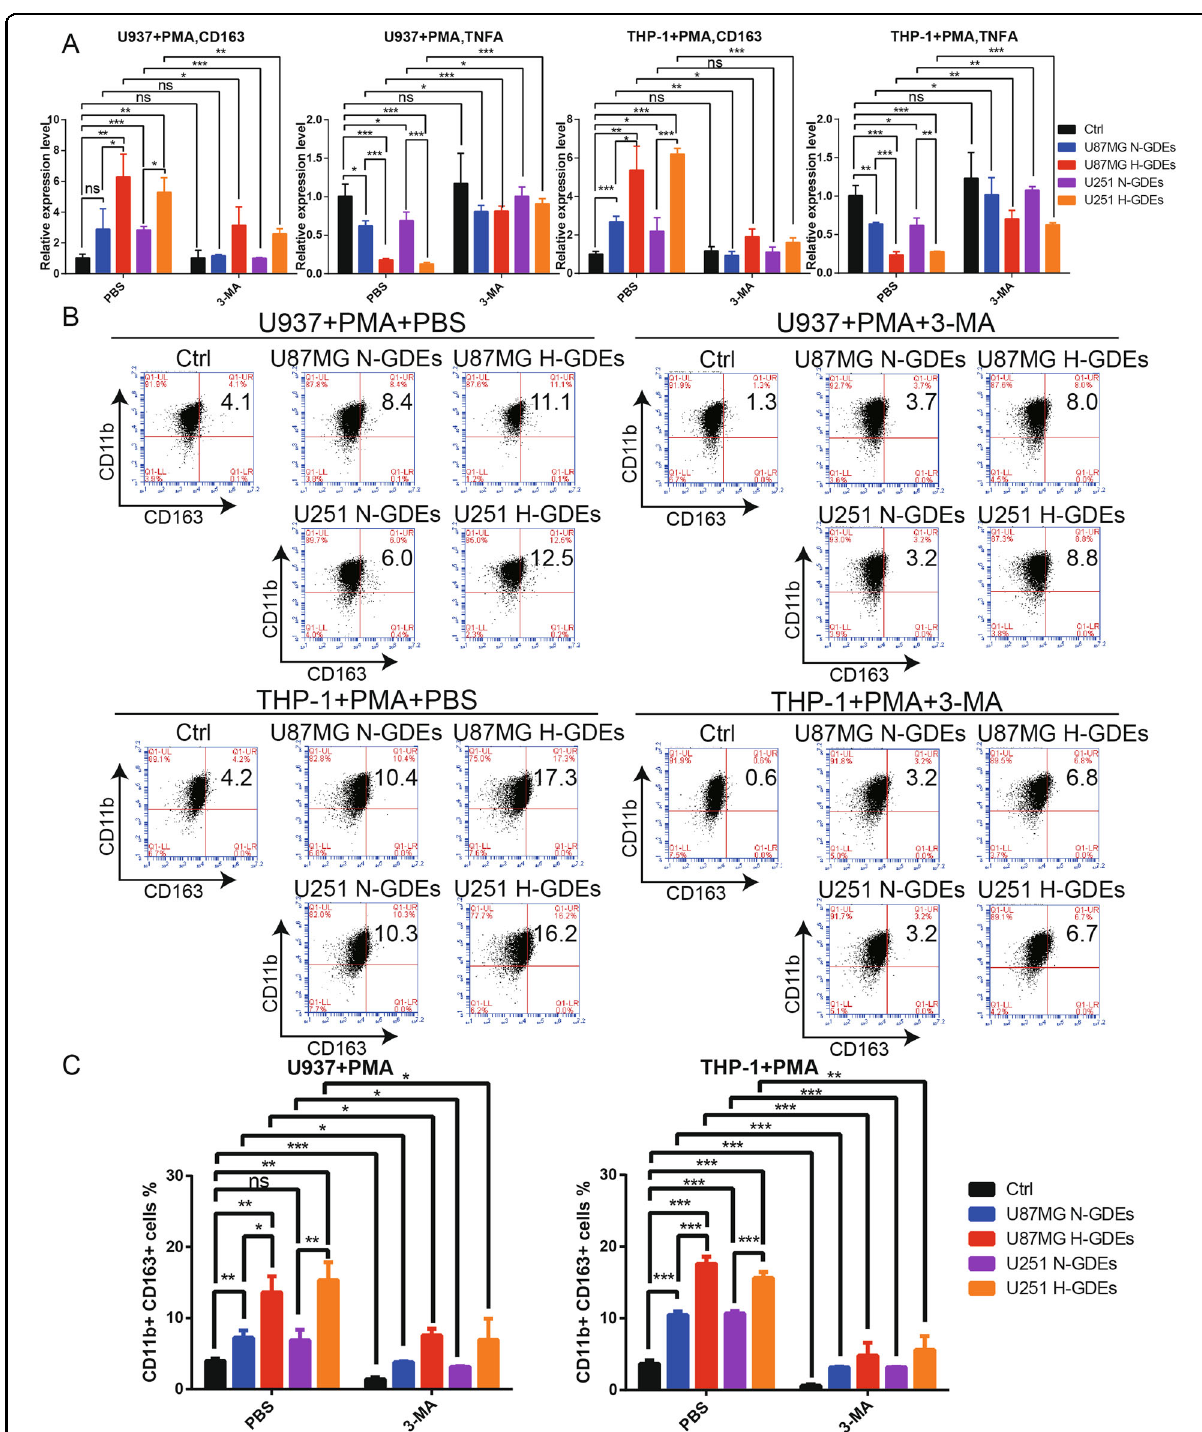
Fig. 2 H-GDEs signi fi cantly induce M2-like macrophage polarization and can be inhibited by 3-MA. A Human monocyte cell lines U937 and THP-1 were incubated with PMA (100 ng/ml) for 24 h in vitro to induce them to differentiate into macrophages. Then, the macrophages were treated with PBS, N-GDEs or H-GDEs isolated from the culture supernatants of U87MG and U251 cells. 3-MA was used to inhibit autophagy. The expression levels of CD163 and TNFA were determined by qRT-PCR. B , C Macrophages were treated in the same way as described in ( A ). Flow cytometry and quanti fi cation were performed to analyze the proportion of CD11b + CD163 + macrophages. (* P < 0.05; ** P < 0.01; *** P < 0.001; n =